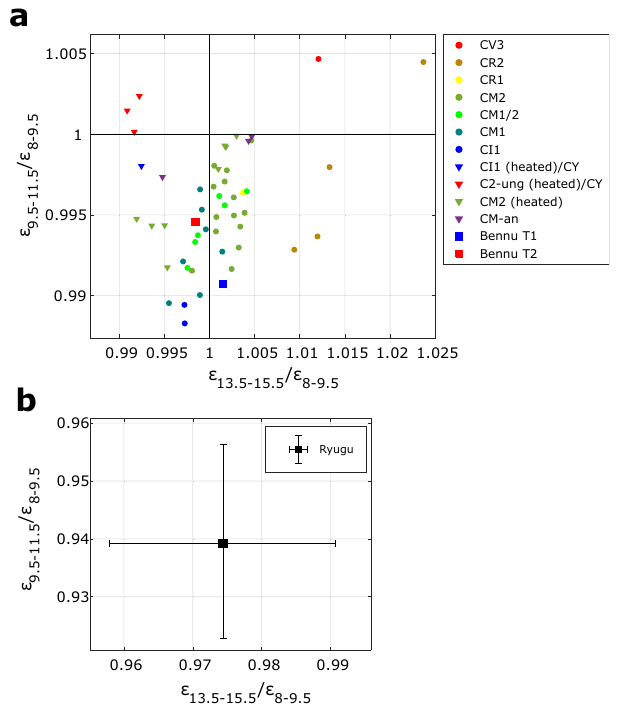
Fig. 6 Comparison of emissivity ratios derived from MARA data to emissivity ratios derived from powdered chondrite samples and Bennu. Emissivity spectra are derived from inverted re fl ectance spectra of powdered samples of carbonaceous chondrites. a Ratios of the re fl ectance and emissivity spectra of various powdered carbonaceous chondrites 19,31,45 – 47 and OTES Bennu spectra 44 , averaged over the instrument function with the 8 – 9.5 µ m, 9.5 – 11.5- µ m and the 13.5 – 15.5- µ m fi lter channels. The aqueously altered chondrites all show decreasing emissivity from 8 – 9.5 to 9.5 – 11.5 µ m, whereas the dehydrated CY and the CV3 (Allende) shows an increase in emissivity in that band. b The emissivity ratios of Ryugu are signi fi cantly lower and far out of bounds compared to panel a . Error bars indicate the 25th and 75th percentile of the estimated band ratios. Source data are provided as a Source Data fi le.